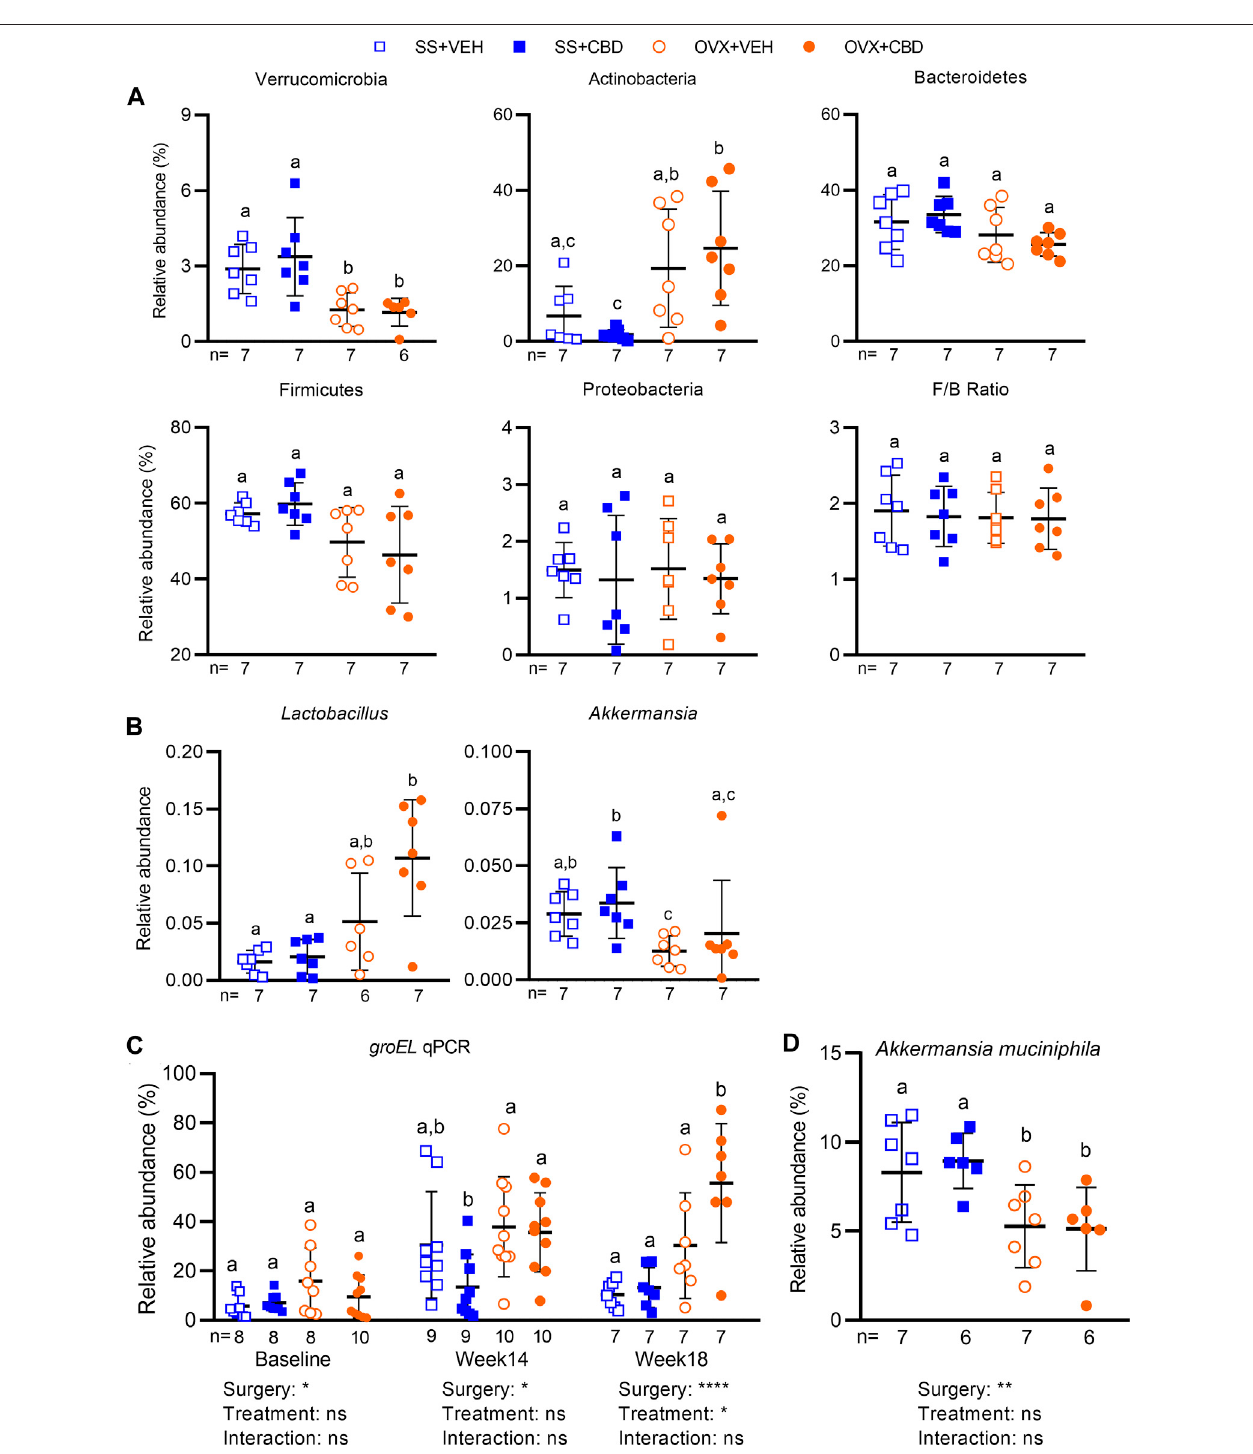
FIGURE 5 | CBD altered the gut microbiota and increased relative abundance of Lactobacillus sp. Relative abundance of amplicon sequence variants (ASVs) identi fi edinfecalgutmicrobiotasamplescollectedafter18weeksofVEHorCBDtreatment( n =7mice/group)classi fi edatthe (A) phylaand (B) generalevelusingaNaïve- Bayestrainedtaxonomicclassi fi erfromtheSilvadatabase.ROUT testwasperformedtodetectoutliers. Differentletters (a – c) indicatesigni fi cantdifferenceasdetermined bythenon-parametricKruskal – Wallistestfornon-normallydistributeddatafollowedbyBenjamini – Hochbergpost-hoctestwithFDR-adjustment,q < 0.05. (C) qPCR using primers speci fi c to variable region of groEL gene to con fi rm relative abundance of Lactobacillus spp. in fecal samples collected at baseline ( n = 8 – 10 mice/group), week14( n =9 – 10mice/group),andweek18( n =7mice/group)afterVEHorCBDtreatment. (D) qPCRtoassessrelativeabundanceof Akkermansiamuciniphila atweek 18 ( n = 7 mice/group) using A. muciniphila speci fi c primers. Data in C and D were normally distributed. ROUT test was performed to detect outliers. Different letters (a,b) indicate signi fi cant difference determined by two-way ANOVA followed by Benjamini – Hochberg post-hoc test with FDR-adjustment, q < 0.05.